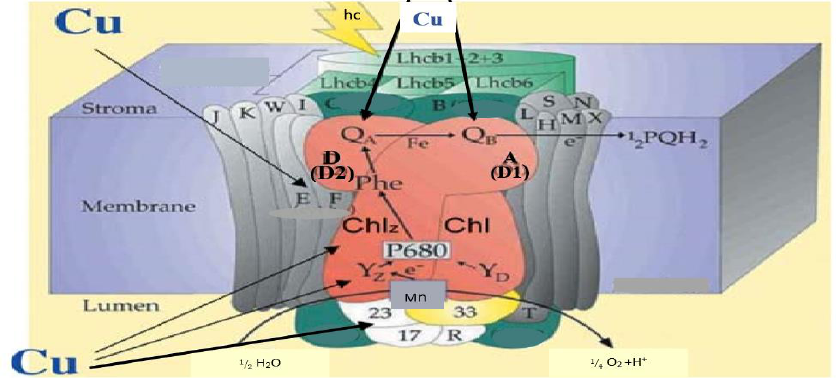
Figure 2. Scheme of copper action sites in phyto system II of plants [36].